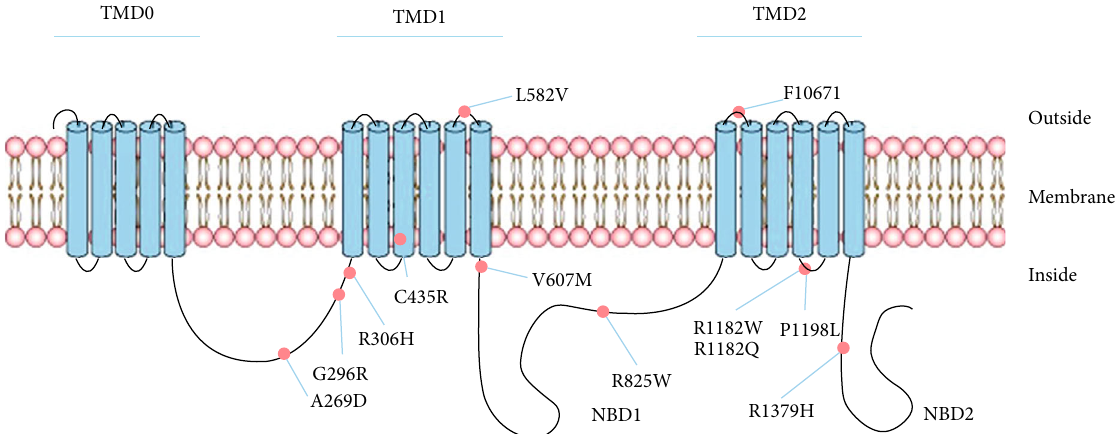
Figure 1: A schematic of the transmembrane topology of SUR1 showing the location of the variants both in ABCC8 -NDM and ABCC8 - NNDM. The transmembrane domains (TMD) include TMD0, TMD1, and TMD2. The nucleotide-binding domains (NBD) are indicated by NBD1 and NBD2, and the cytosolic linker L0 is between TMD0 and TMD1. ABCC8 -NDM: ABCC8 -induced neonatal diabetes mellitus; ABCC8 -NNDM: ABCC8 -induced nonneonatal diabetes